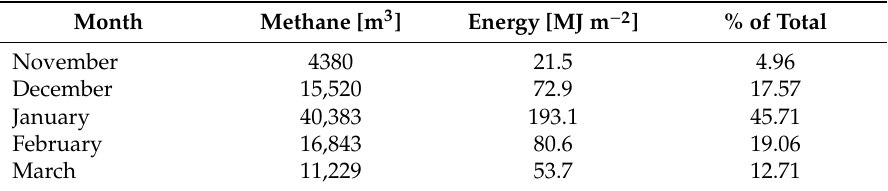
Table 2. Monthly consumption of methane [m 3 ] in 2018–2019